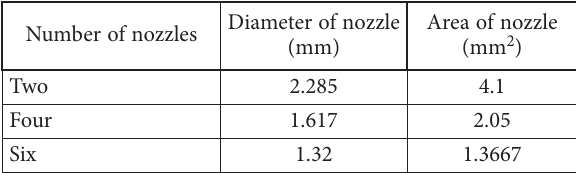
Table 4. Information on the different inlet nozzles